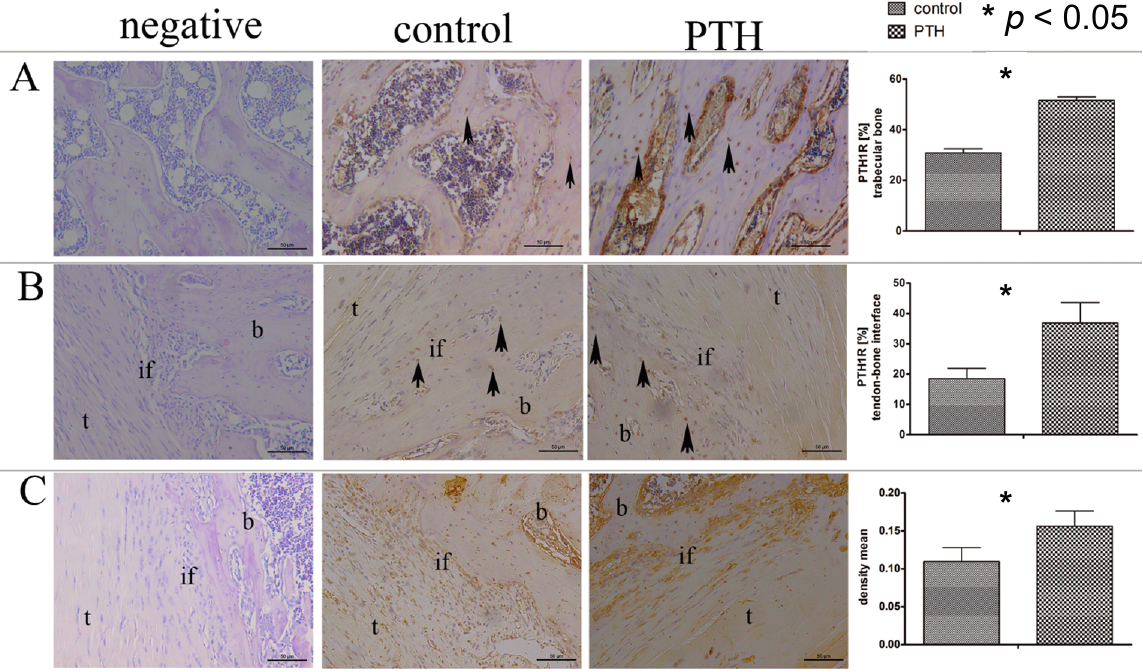
Figure 3. PTH1R expression in the trabecular bone ( A ) and tendon-bone interface ( B ) was up-regulated following PTH[1–34] administration. The arrows ( A , B ) point at some of the positive stained cells; ( C ) The density mean of immunoreactivity to osteocalcin at the tendon-bone interface of the PTH group was higher than that of the control group. Negative controls (left images in A – C ) show immunostaining with the omission of primary antibody. Scale bar: 50